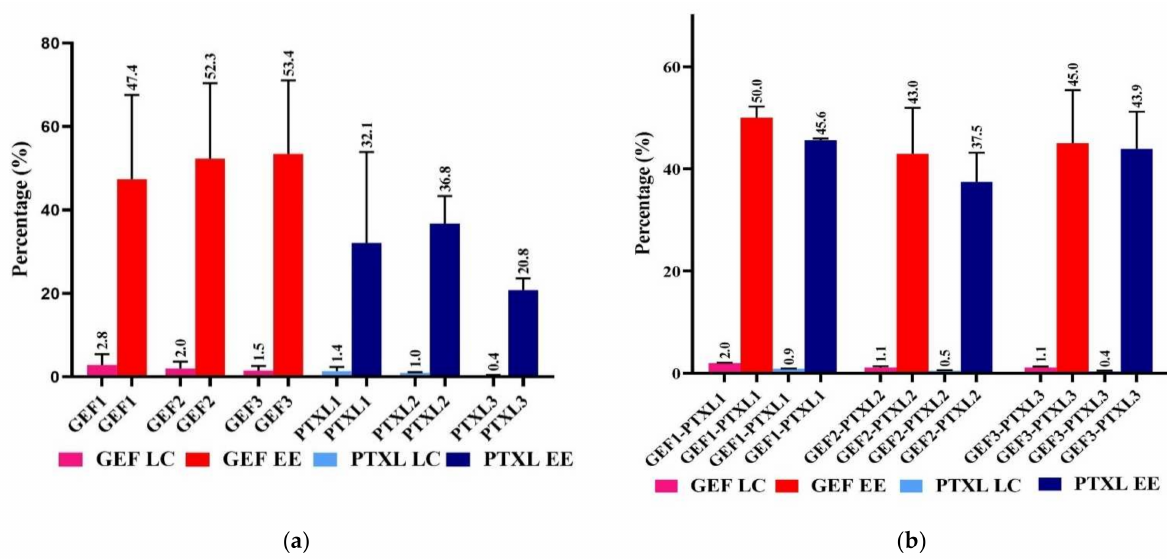
Figure 2. Loading Content (LC) and Entrapment efficiency (EE): ( a ) Mono GEF and PTXL in three individual groups of CSCaCO 3 nanoparticle formulations; ( b ) Dual GEF+PTXL in three groups of CSCaCO 3 nanoparticle formulations. The error bar is indicated for the corresponding columns, and the mean data are shown above the error bar. LC, loading content; EE, entrapment efficiency; CSCaCO 3 NP, Blood cockle shell derived CaCO 3 nanoparticles; GEF, Gefitinib; PTXL, Paclitaxel; GEF 1-3, groups of GEF loaded CSCaCO 3 NP; PTXL 1-3, groups of PTXL loaded CSCaCO 3 NP; GEF 1-3, PTXL 1-3, and GEF1-3-PTXL1-3 are groups of GEF loaded CSCaCO 3 P, PTXL loaded CSCaCO 3 NP, and GEF-PTXL loaded CSCaCO 3